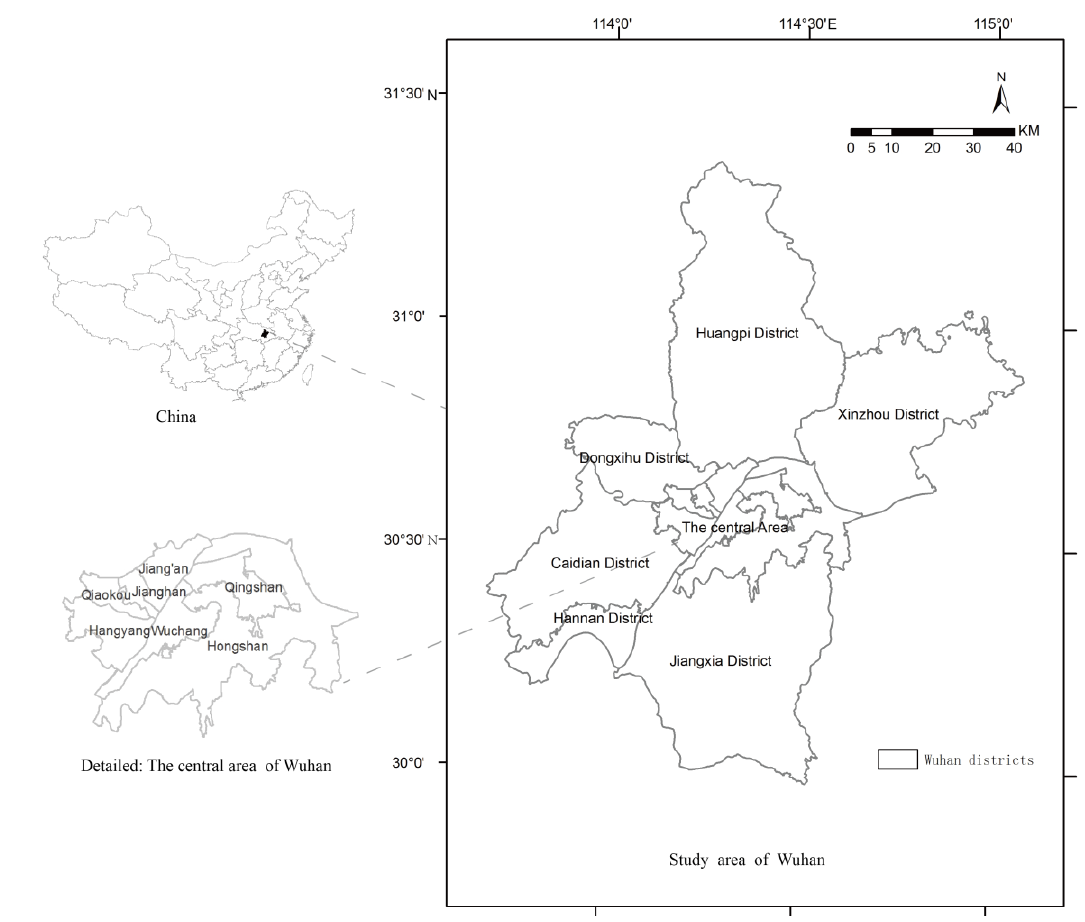
Figure 1. Location of the study area.